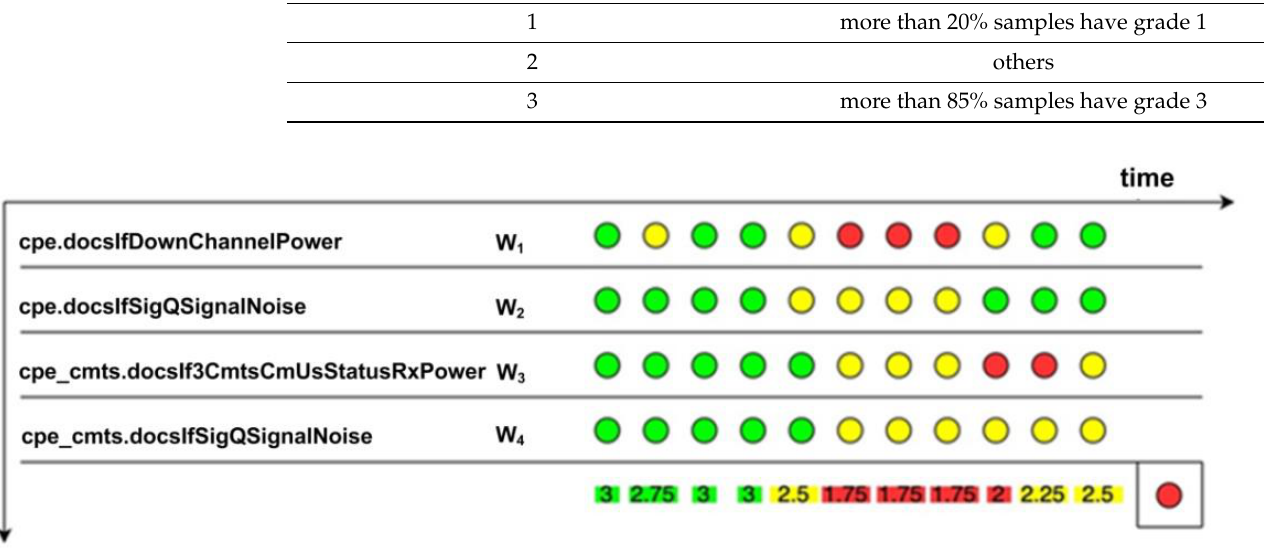
Table 7. Thresholds for the performance grade of non-intelligent